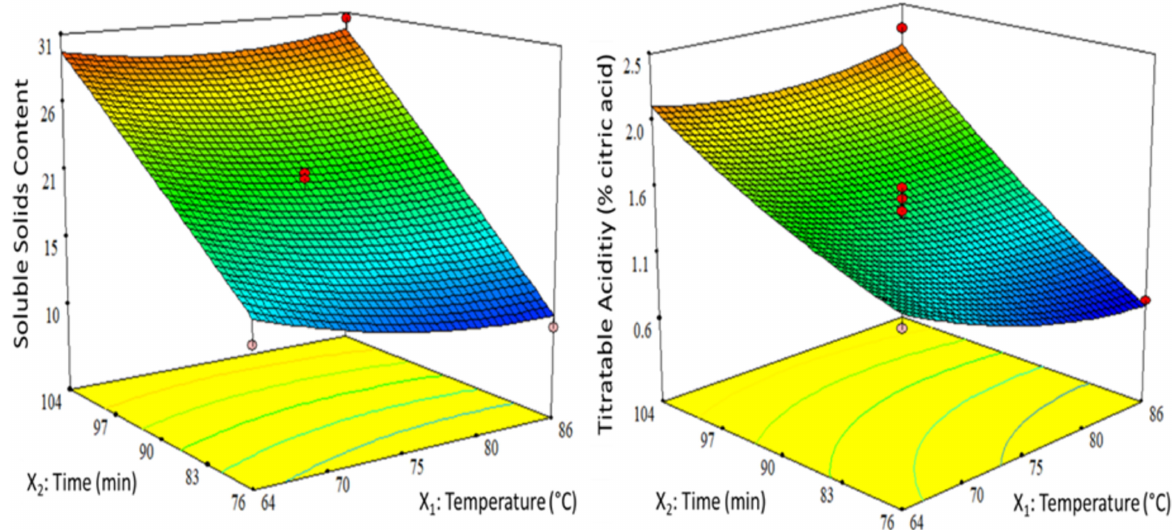
Figure 1. Calculated effects of process variables; cooking temperature and cooking time on soluble solid content and titratable acidity of vacuum evaporated tomato